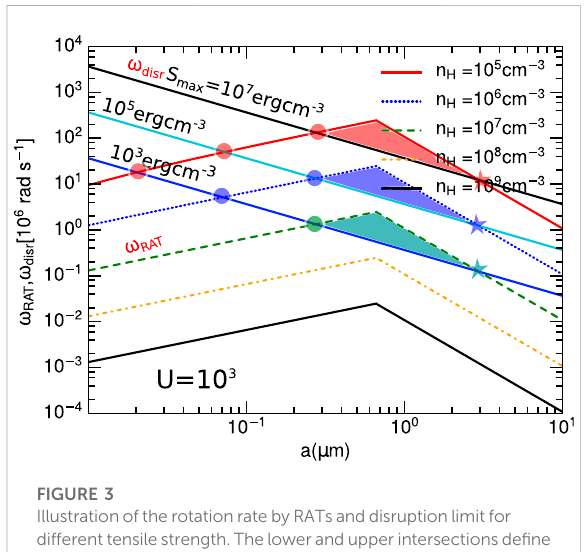
FIGURE 3 IllustrationoftherotationratebyRATsanddisruptionlimitfor differenttensilestrength.Thelowerandupperintersectionsde fi ne the lower and upper disruption sizes. Figure adopted from Hoang